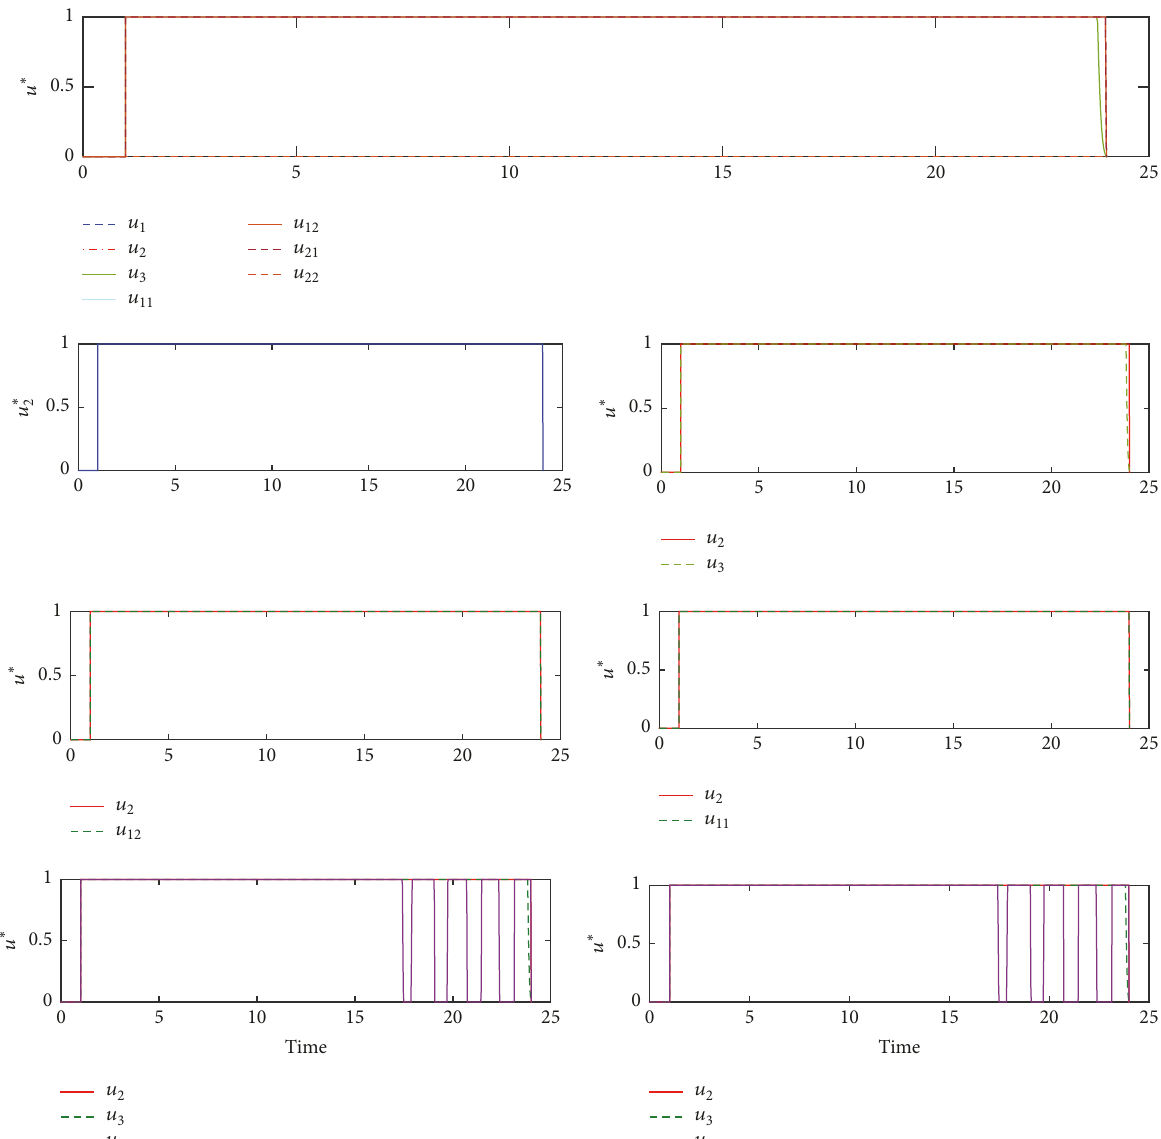
Figure 3: Plots showing control profiles for the different strategies (D), (A), (B1), (B2), (B3), (C1), and (C2), respectively, when quadratic cost terms are considered. The graphs are maintained at maximum value in all strategies for debudding and roguing. Parameters are as given